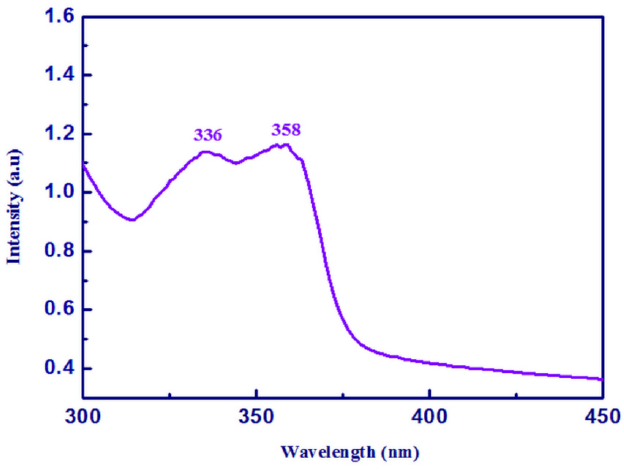
Figure 8. Solid-state emission spectrum of (C 2 H 7 N 4 O) 2 BiCl 5 upon an excitation at 270 nm.